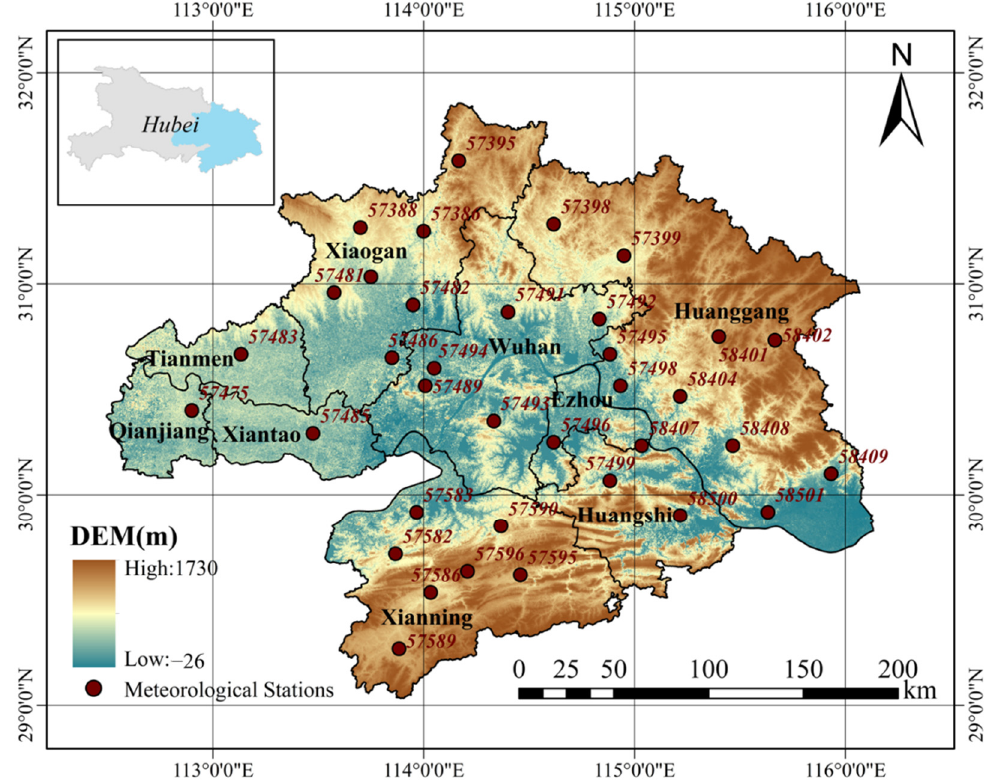
Figure 1. The geographical location of WMA. The points represent the meteorological stations.